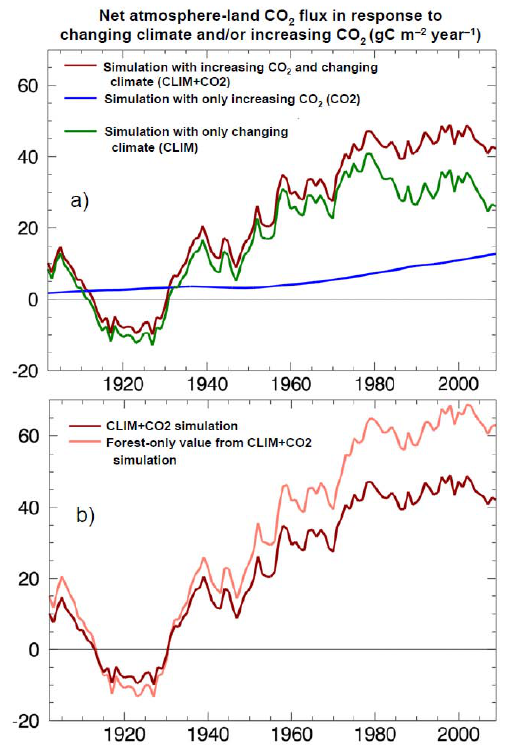
Fig. 5. (a) BC-wide simulated net atmosphere–land CO 2 flux (gC m − 2 yr − 1 ) , in response to changing climate and/or CO 2 concentra- tion, during the 1900–2010 period for three historical simulations – CO 2 , CLIM and CLIM + CO 2 – as explained in Sect. 2.4. The lines are 10yr moving averages. Positive values indicate a carbon sink over land, and negative values imply a source of carbon to the at- mosphere. (b) Forest-only net atmosphere–land CO 2 flux compared to province-wide averaged net atmosphere–land CO 2 flux from the CLIM + CO 2 simulation, excluding the impacts of forest insect dis- turbances and